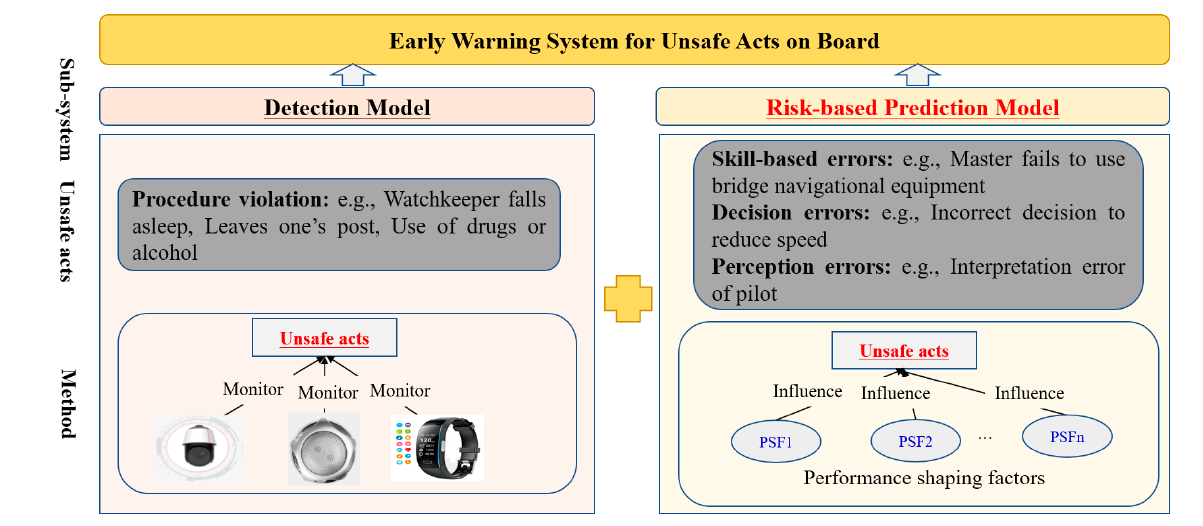
Figure 3. Detection and prediction of unsafe crew acts.